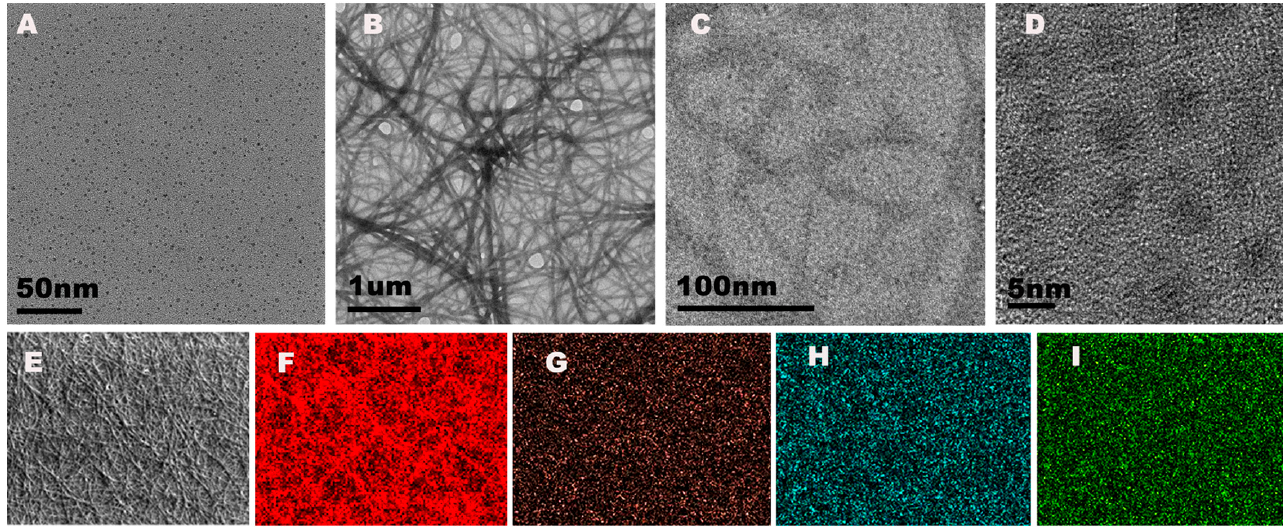
Figure 1. ( A ) TEM image of NCDs; ( B ) TEM image of Ir–NCDs; ( C , D ) magnified topography of Ir–NCDs at different magnifications; ( E ) original image of mapping characterization of Ir–NCDs; and ( F – I ) elemental distribution of Ir, C, N, and O, respectively.